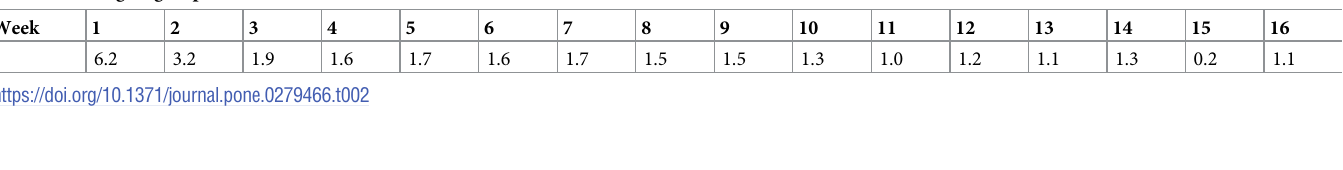
Table 2. Average logins per